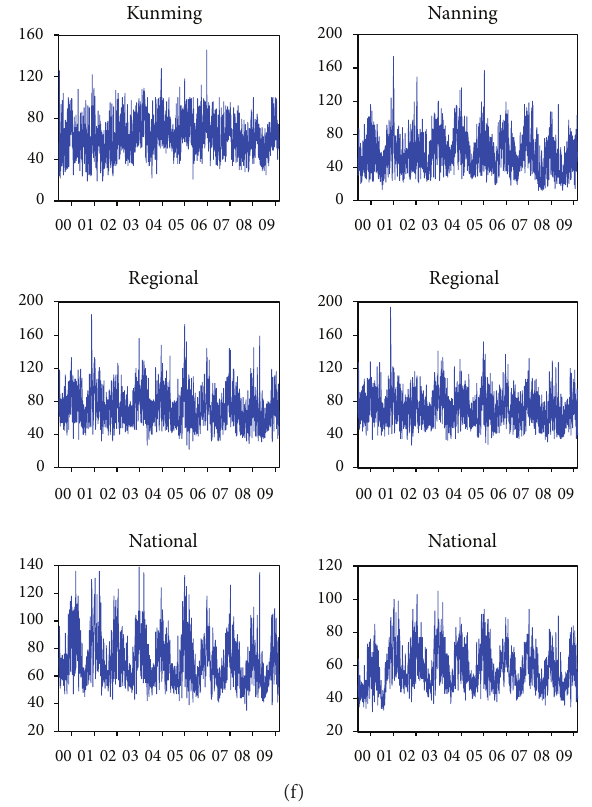
Figure 1: APIs for 42 sample cities and corresponding regional and national